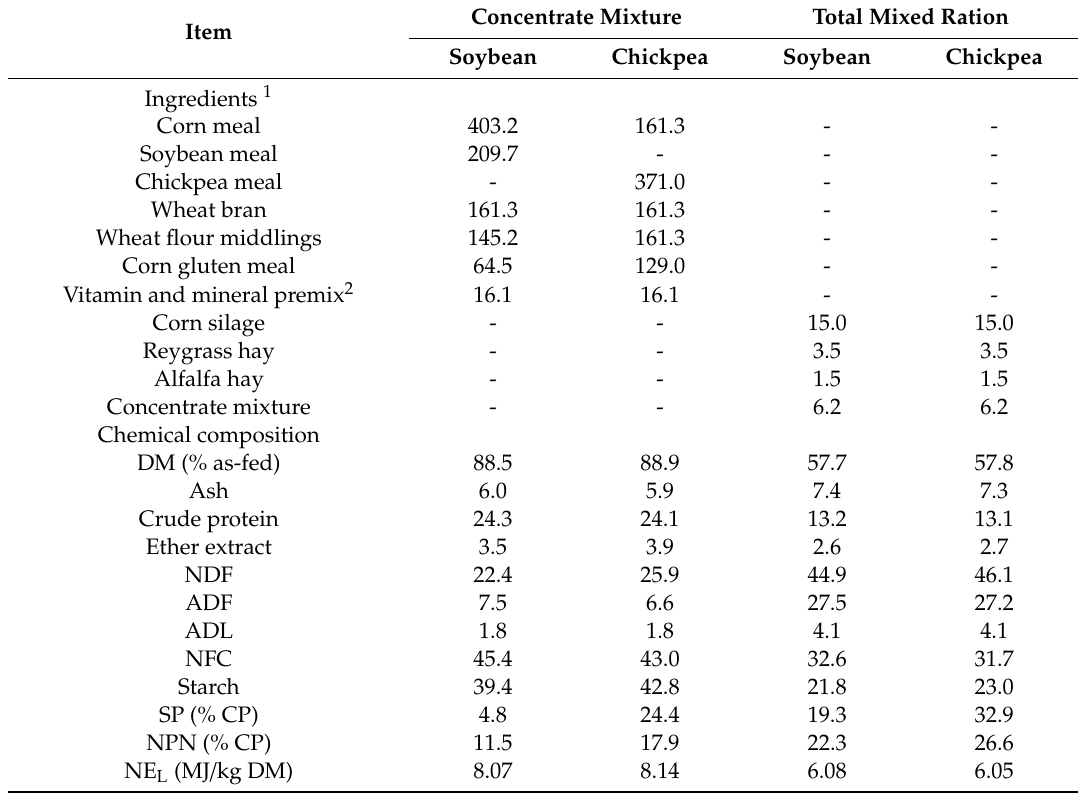
Table 2. Ingredients and chemical composition (% of dry matter, DM, if not otherwise stated) of the experimental concentrates mixture and total mixed rations. Concentrate Mixture Total Mixed